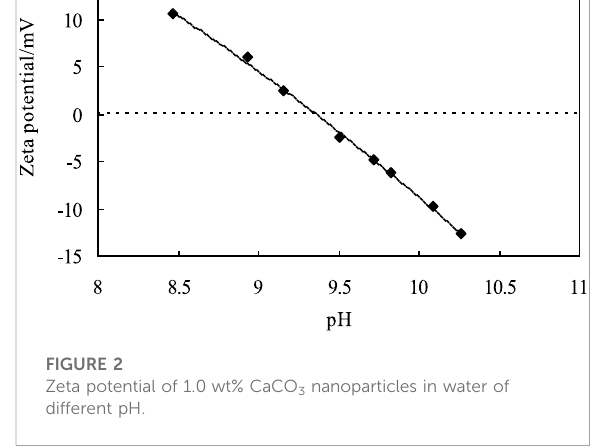
FIGURE 4 Appearance of toluene-in-water emulsions stabilized solely by CaCO 3 nanoparticles, taken 1 week after preparation. Particle